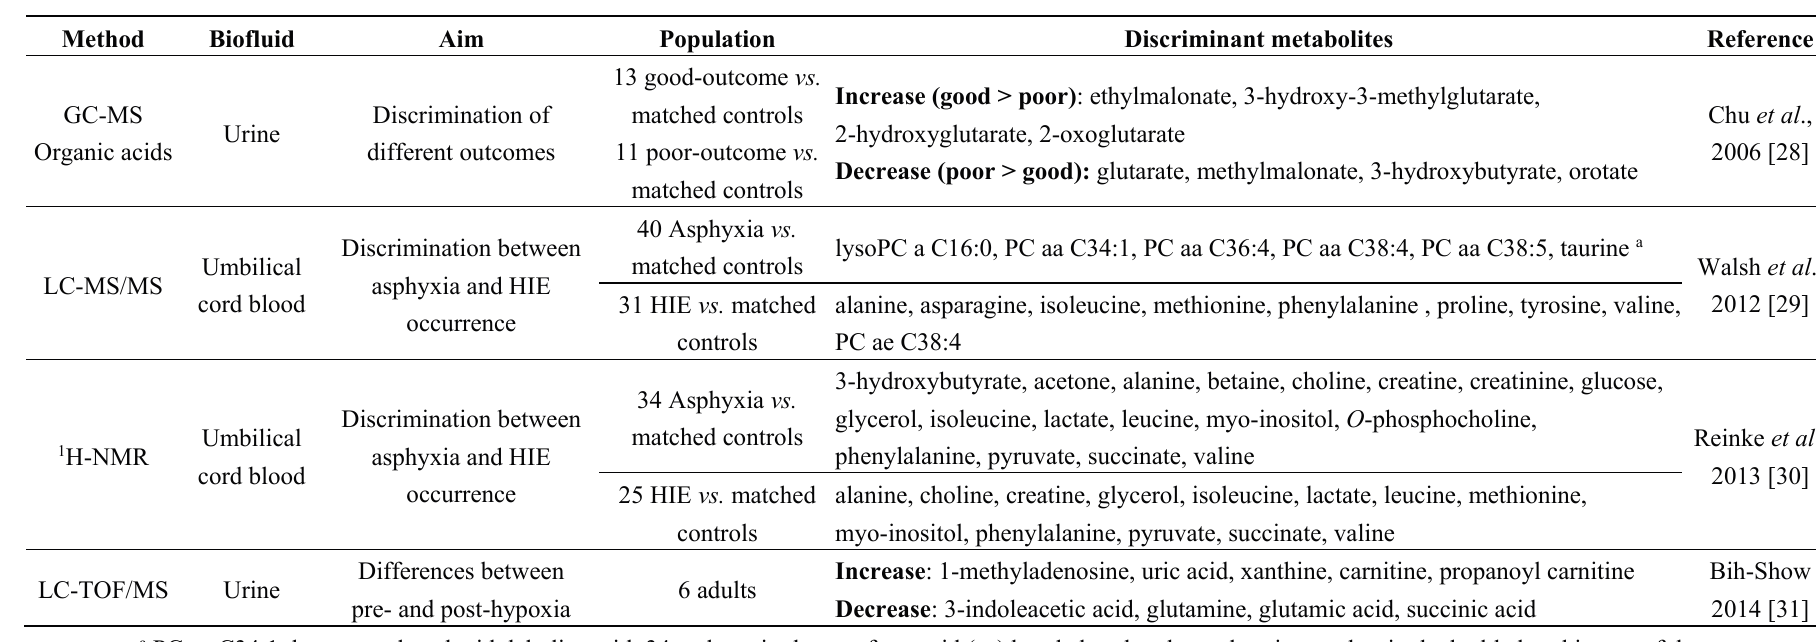
Table 2. Metabolomic analysis on human